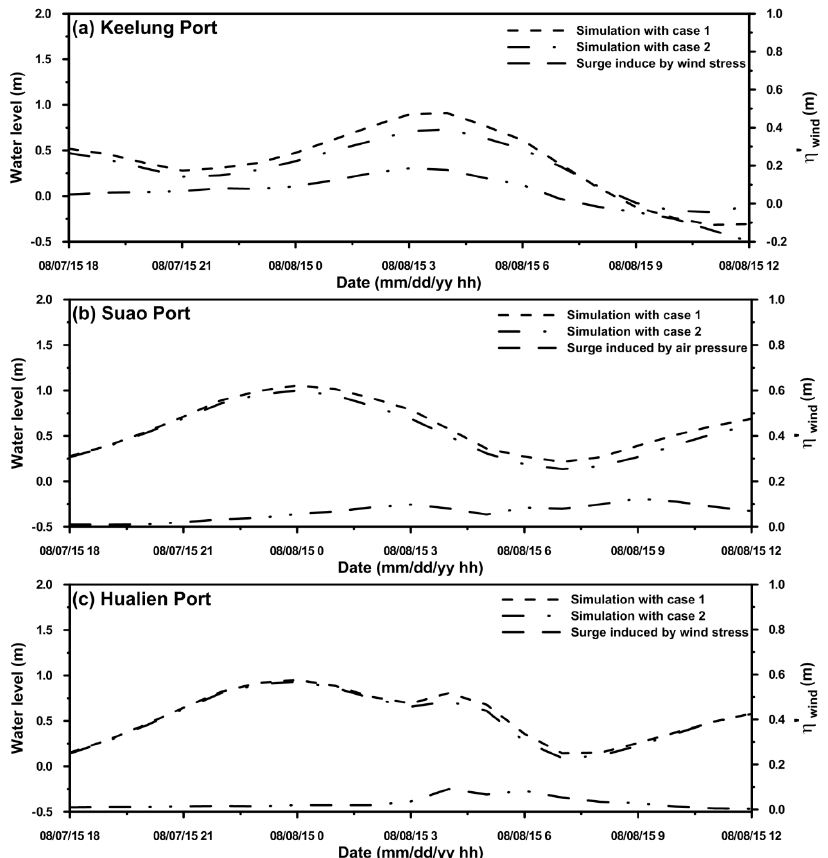
Figure 10. Comparison of the simulated water level between Case 1 and Case 2 and the calculated wind induced surge at: ( a ) Keelung Port; ( b ) Suao Port; and ( c ) Hualien Port during Typhoon Soudelor (2015).